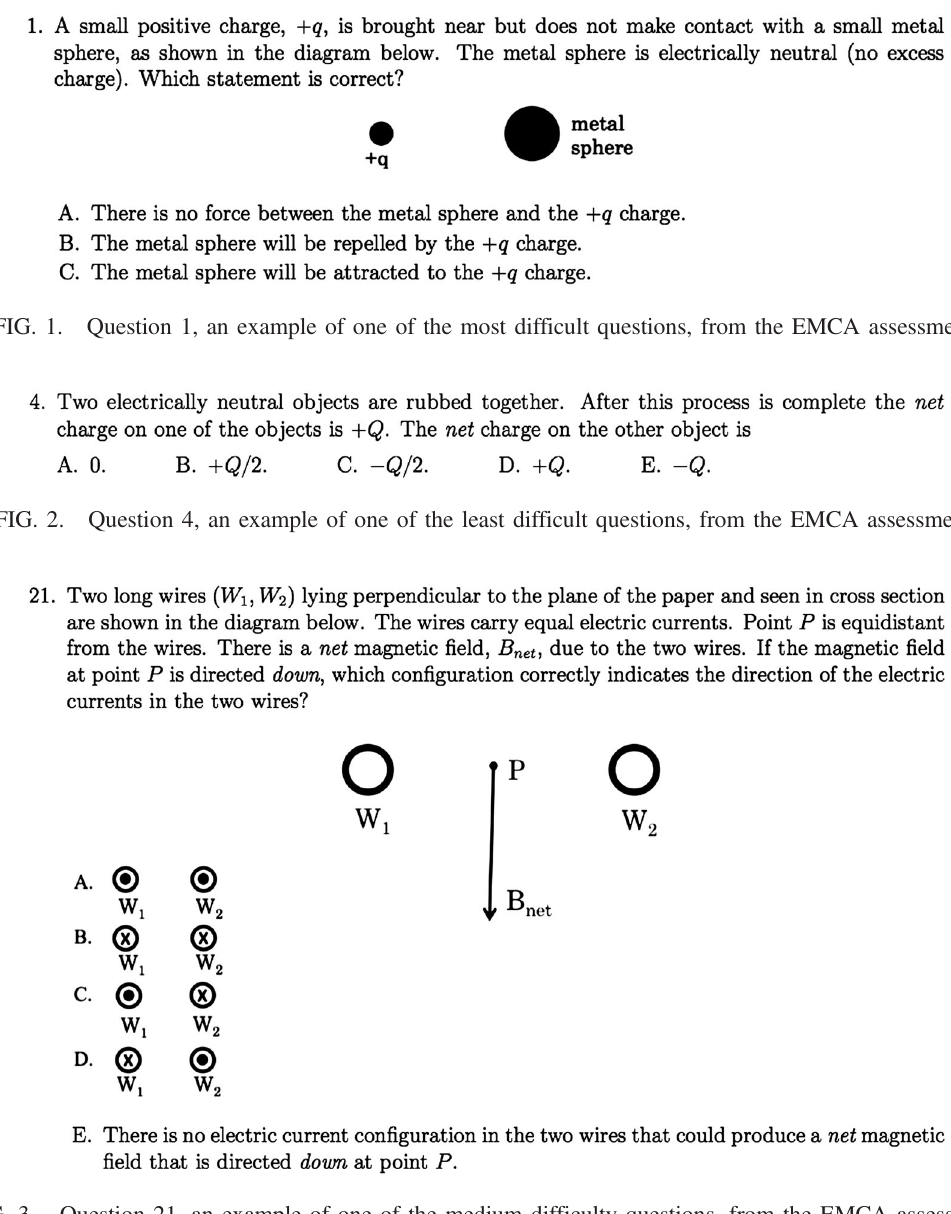
FIG. 3. Question 21, an example of one of the medium difficulty questions, from the EMCA